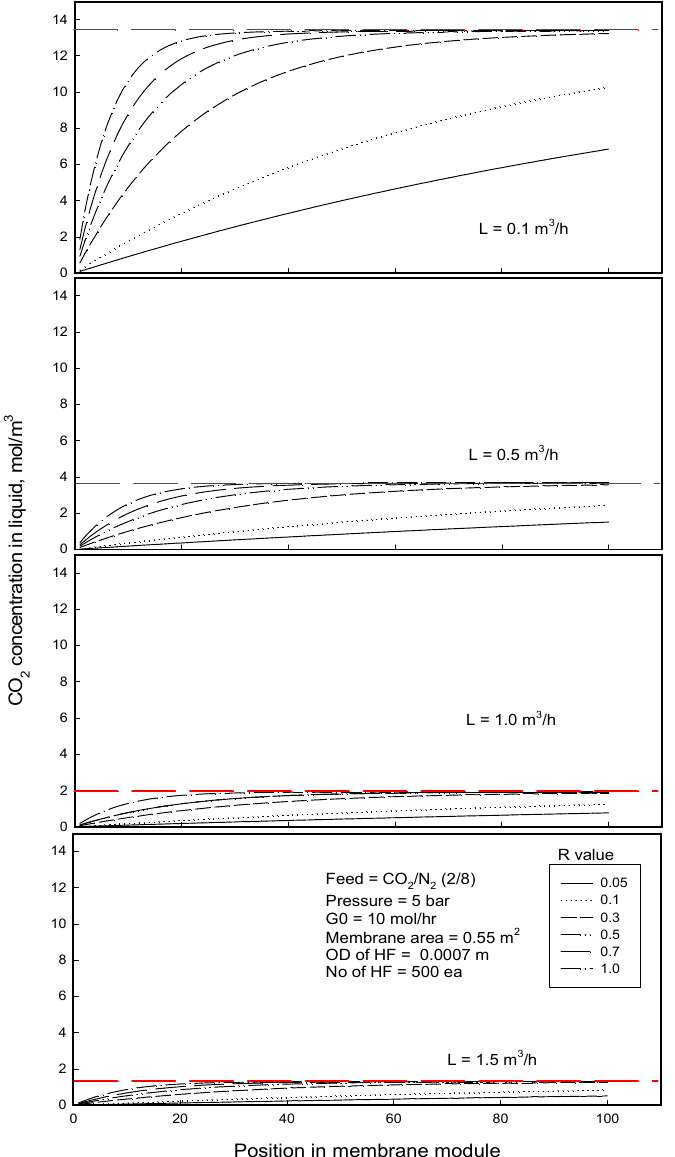
Figure 10. CO 2 concentration in liquid stream with the position of module length in gassing process for the separation of CO 2 /N 2 mixture: red broken line = x E , equilibrium CO 2 concentration in the liquid stream.